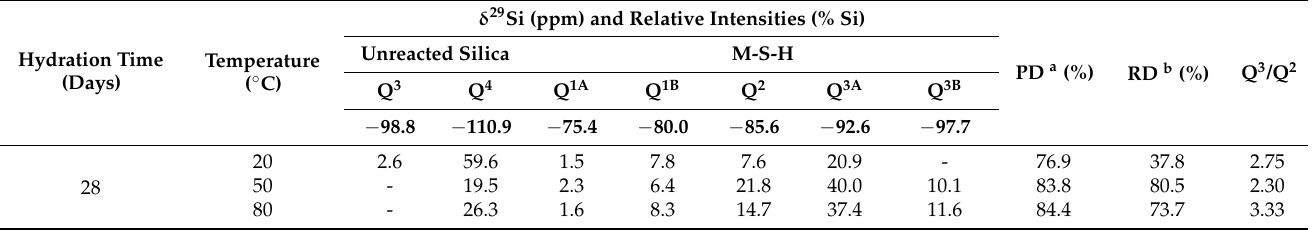
Table 6. Relative intensities of different silicon sites calculated using the 29 Si MAS NMR spectra of MgO-SF pastes ( δ 29 Si in ppm ± 0.6